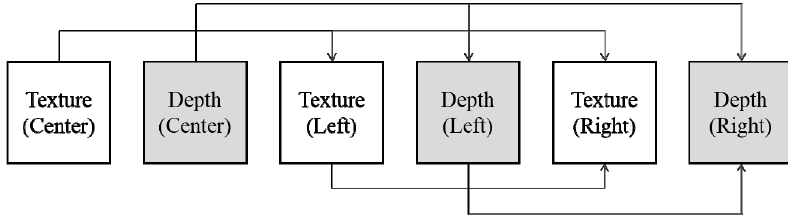
Figure 9. Inter-view prediction structure (P-I-P) in the three-view configuration.